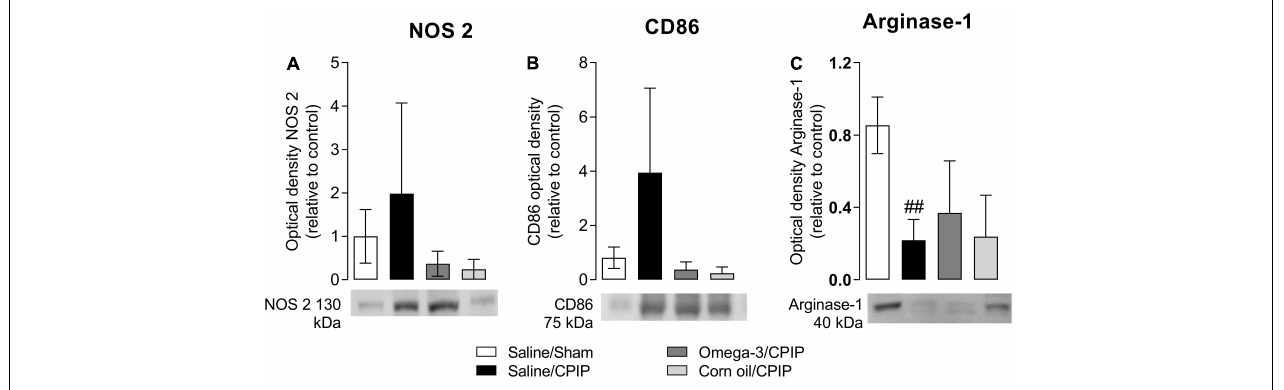
FIGURE 5 | Effects of omega-3 supplementation on the immunocontent of macrophages M1 markers: nitric oxide synthase 2 (NOS-2) (A) and CD86 (B) , and M2 marker: Arginase-1 (C) on the mouse paw muscle 48 h after the model induction in Saline/Sham, Saline/CPIP, Omega-3/CPIP, and Corn oil/CPIP groups. Data are expressed as mean ± SD of 6 animals per group, statistically assessed by the one-way ANOVA followed by Tukey’s test. ## p < 0.01 vs. the Saline/Sham group.